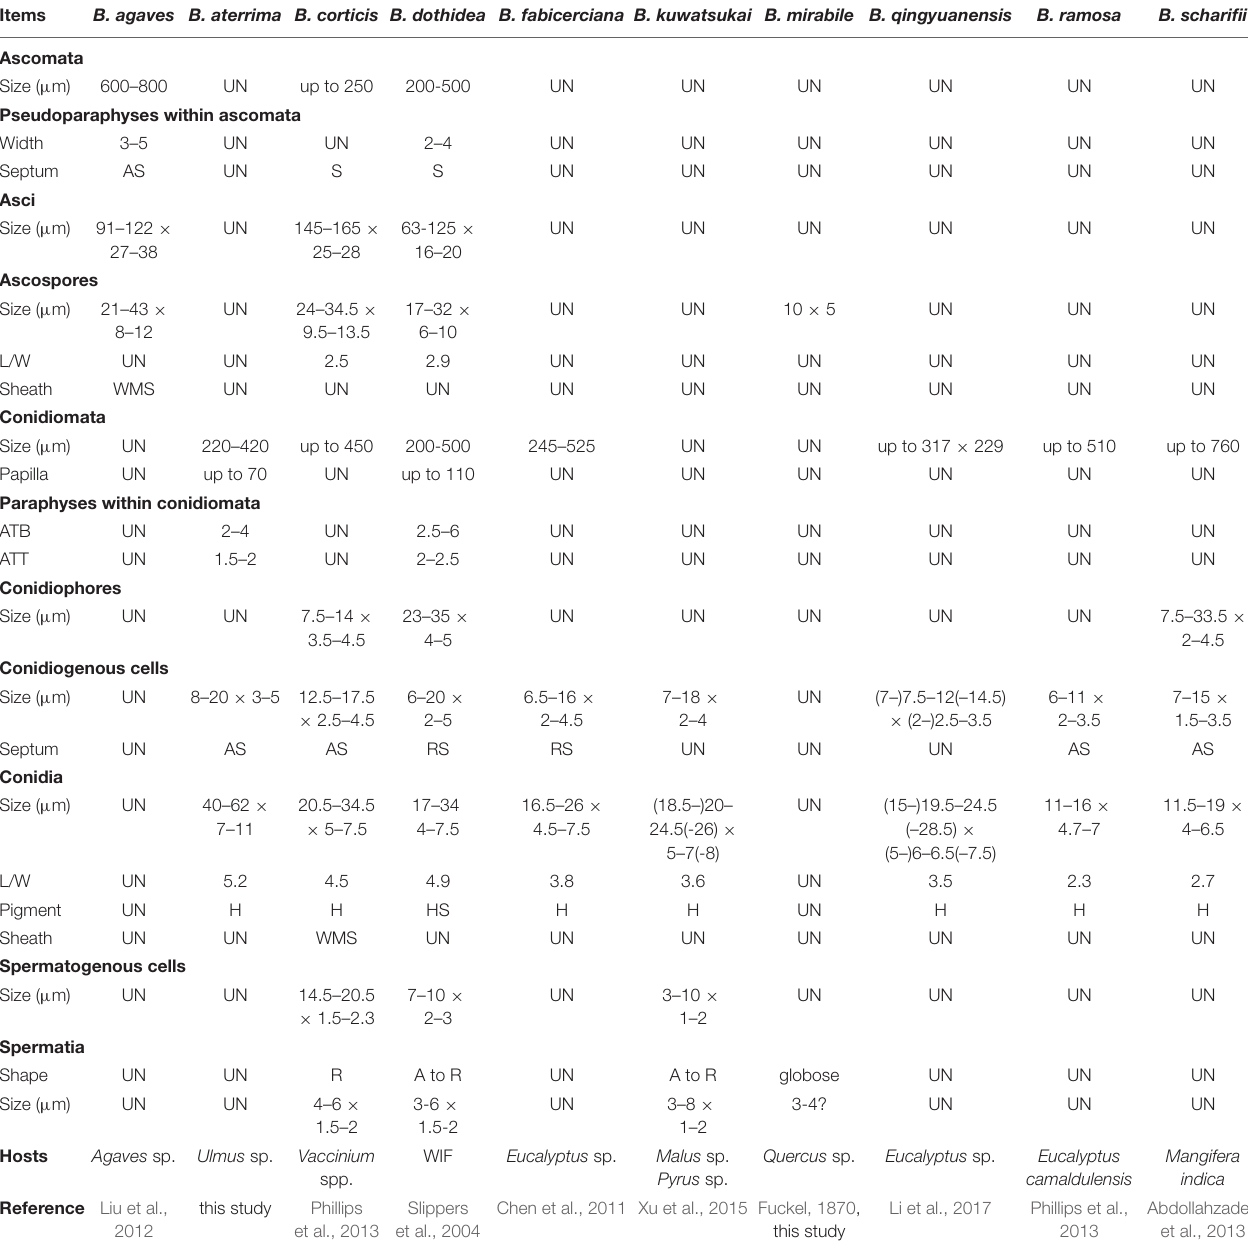
TABLE 2 | Morphological characteristics of Botryosphaeria spp. surely assigned within Botryosphaeria so